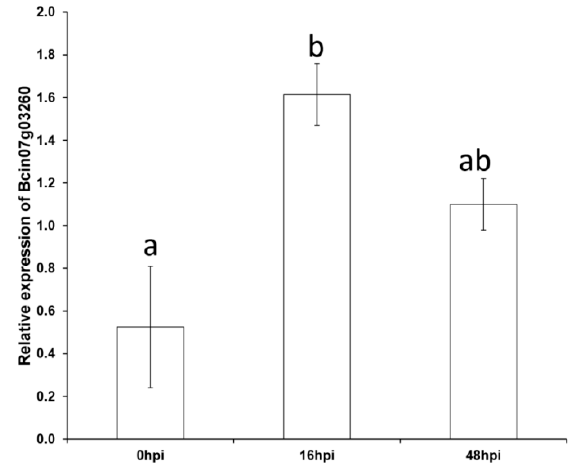
Figure 4. Expression levels of CFEM- Bcin07g03260 encoding for the predicted membrane protein in WT. Gene expression levels were monitored by real-time qPCR from infected tomato leaf tissue of whole plants (at 0, 16, and 48 h post infection; two independent biological replicates per treatment). The y axis represents fold change compared with the housekeeping gene encoding for ubiquitin-conjugating enzyme (UCE), based on Δ Ct values. ANOVA showed a significant difference between time points ( p value < 0.05). Different letters indicate a significant difference between pairs (e.g., 0 hpi vs. 16 hpi) based on Tukey HSD ( p value < 0.05). Error bars represent ±SE.